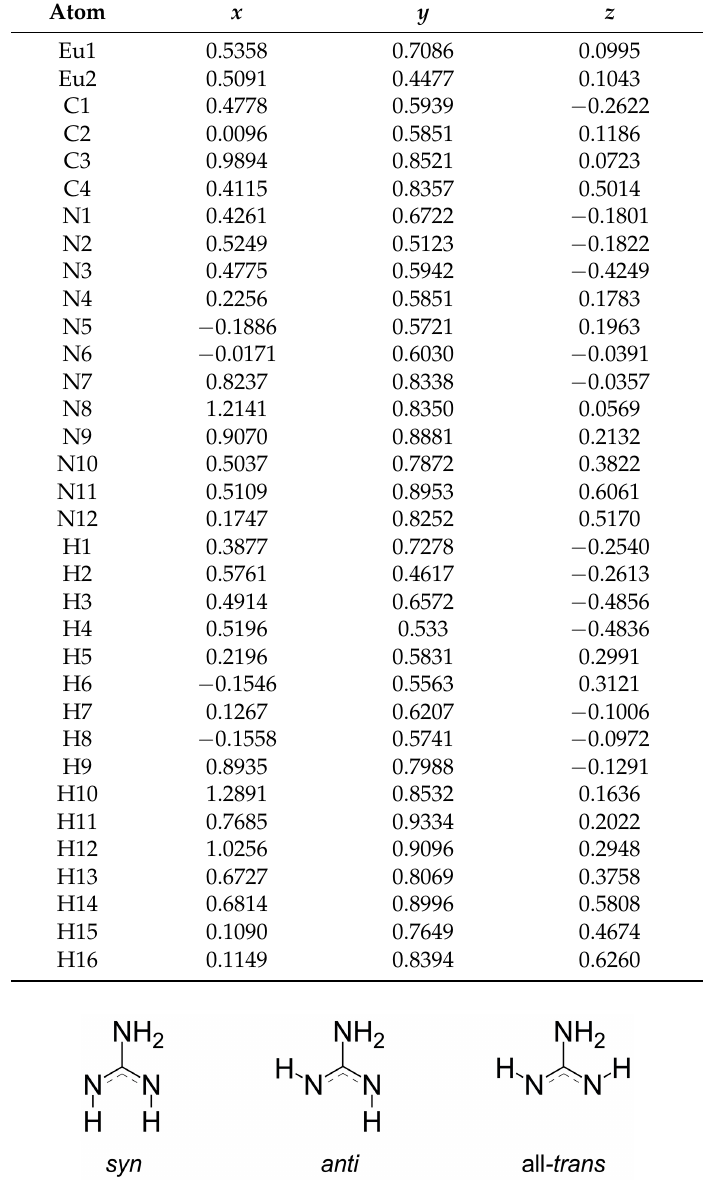
Figure 6. Possible conformations for the singly deprotonated guanidinate CN 3 H 4 − .